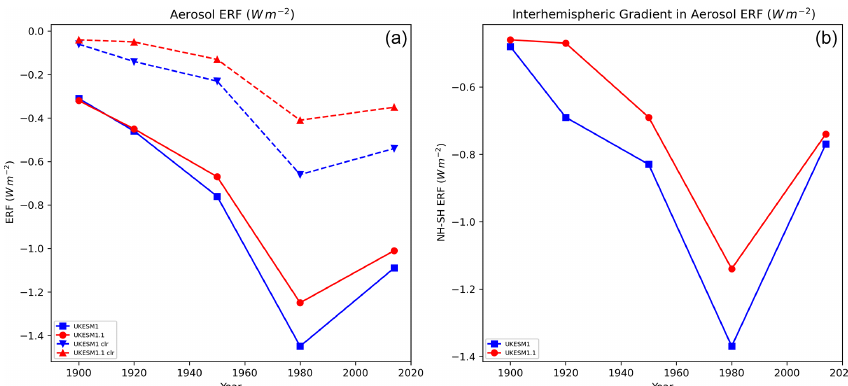
Figure 21. (a) Time series of the historical aerosol ERF from UKESM1 (blue) and UKESM1.1 (red) for all-sky (solid) and clear-sky (dashed lines) conditions. The aerosol ERFs are calculated for selected time slices along the historical period. (b) Interhemispheric gradient in aerosol ERF for each time